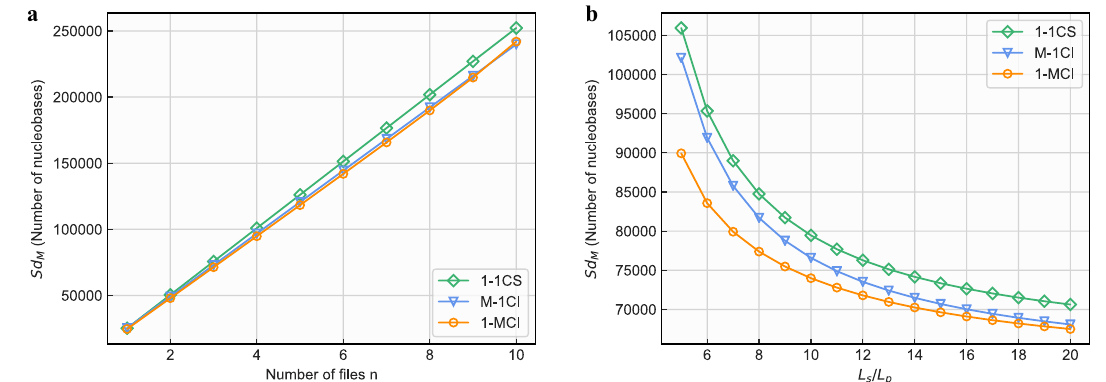
Figure 10. Number of bases that need to be stored for each self-containment method. ( a ) Illustrates how the Sd M changes when the number of files n varies. All three methods show a clear linear trend, and the 1-1CS method requires the highest DNA storage capacity compared with its counterparts. Both 1-MCI and M-1CI show a relatively lower DNA base storage capacity. ( b ) Presents the trend of Sd M when the L s / L p ratio changes. A clear decreasing trend is observed, and the descending speed slows down when the ratio becomes larger. Again, the 1-1CS requires the highest amount of DNA storage, followed by the M-1CI. 1-MCI achieves the lowest DNA base storage due to the effectiveness brought by the data redundancy avoidance. Note that we set the parameters S h = 10 , S T = 2010 , L p = 20 , and a = 1 / 1.6 during experiments. S D is set to be 100000 to make sure that the size of data far exceeds the size of primers. r c is 0.34 for the 7z compression algorithm. L s is also greater than L p , it varies between 100 and 400 to achieve a ratio ranging between 5 and